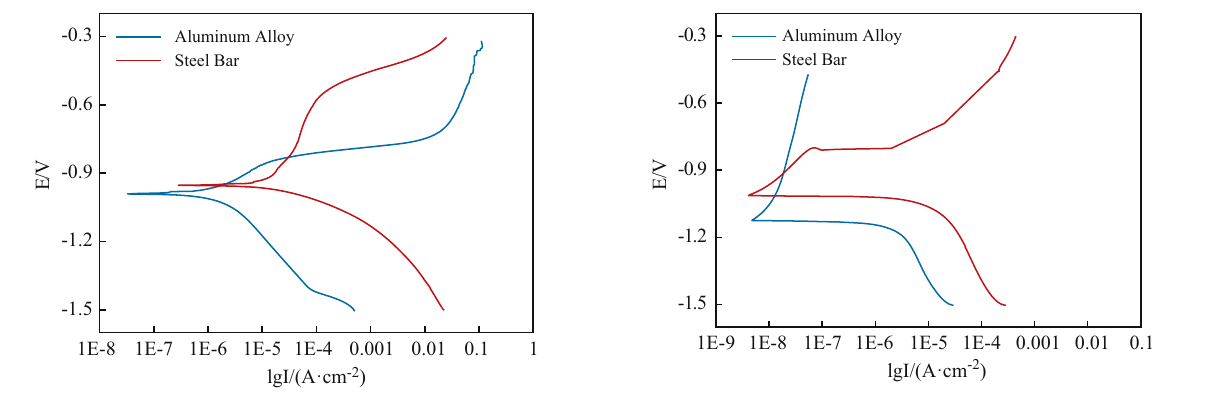
Figure 10: Polarization curves of steel bar and aluminium alloy in the simulated acid rain solution.